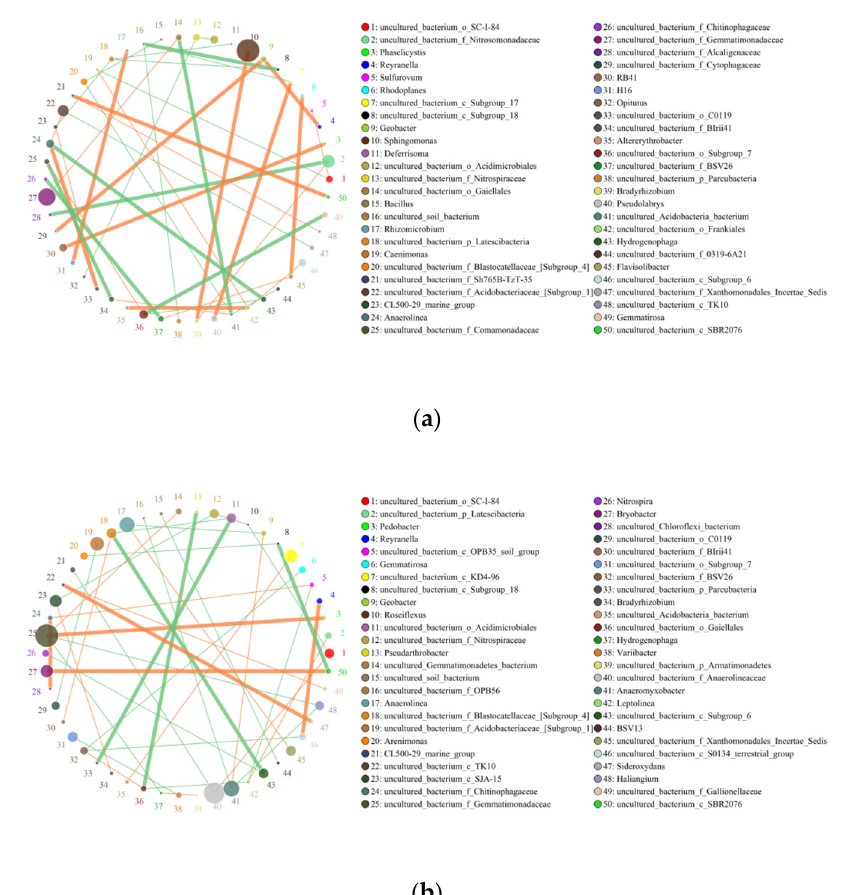
Figure 6. Interaction networks of the main bacterial genera in the soil: ( a ) ridge tillage at two fertilizer depths ( L ); ( b ) conventional cultivation ( P ). Orange and green lines represent positive and negative correlations, respectively; line thickness represents correlation coefficient, and line number represents the degree of closeness between nodes.